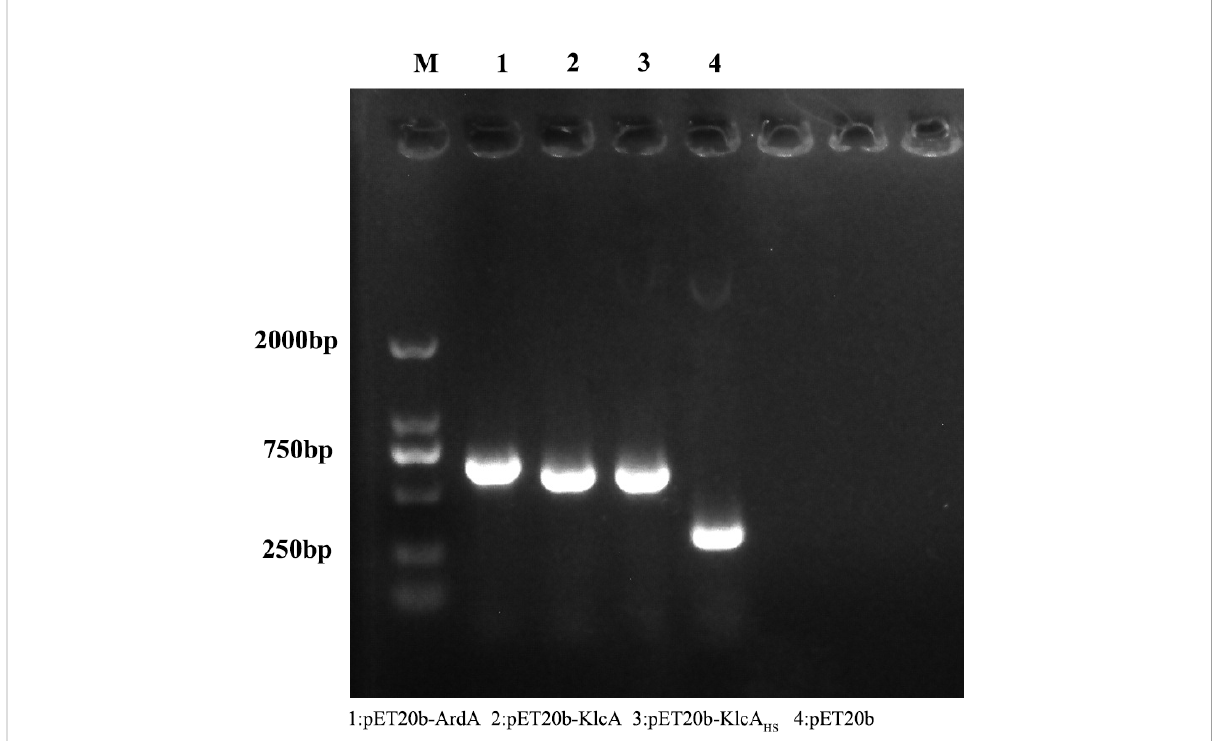
FIGURE 1 The fi gure shows the results of agarose gel electrophoresis of the recombinant protein plasmid and the empty plasmid pET20b ampli fi ed with T7/T7T primers.